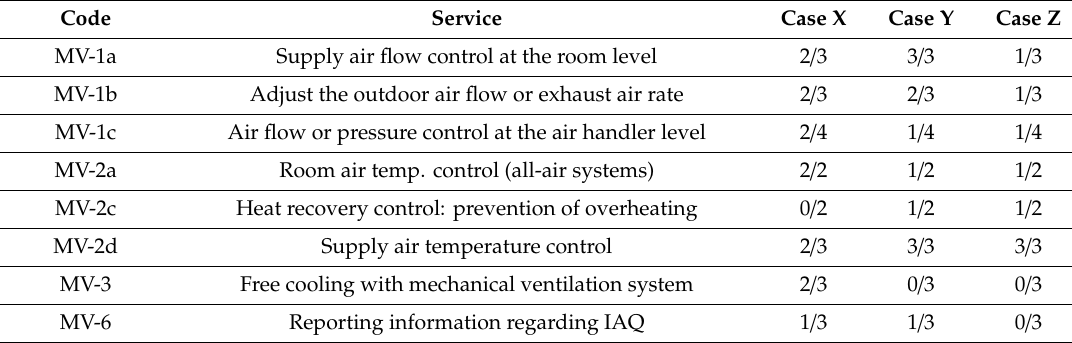
Table 6. The functionality levels in the main domain of mechanical ventilation